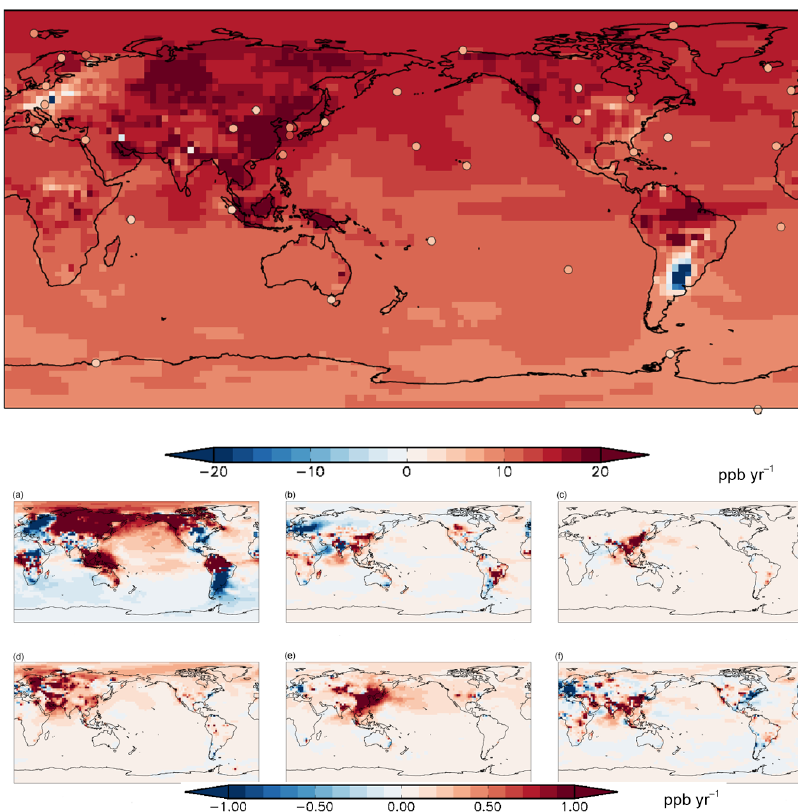
Figure 14. (Upper panel) Mean year-to-year growth (ppbyr − 1 ) in surface CH 4 in Oslo CTM3 over the period 2007–2009. The 36 circles show the observed growth rates over the same period. The stations picked for comparison are based on the criteria described in Sect. 2.3, and only observation sites that have measurements available for all months within the given time is included. (a – f) Mean year-to-year growth (ppbyr − 1 ) in mole fraction of emission tracers in the same period. (a) Natural (wetlands + other natural + biomass burning), (b) enteric, (c) agricultural soils, (d) gas, (e) solid fuel, (f) the sum of all other anthropogenic